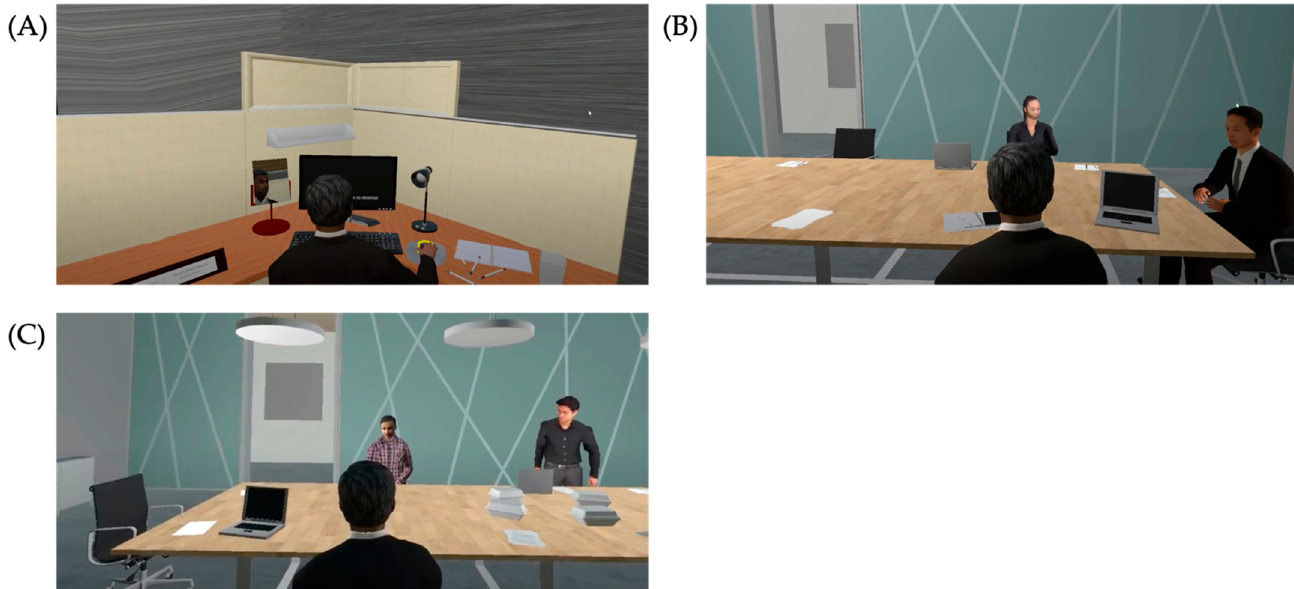
Figure 4. Screenshots depicting ( A ) scene 1, ( B ) scene 2, and ( C ) scene 3 in Study 2 (third-person perspective).